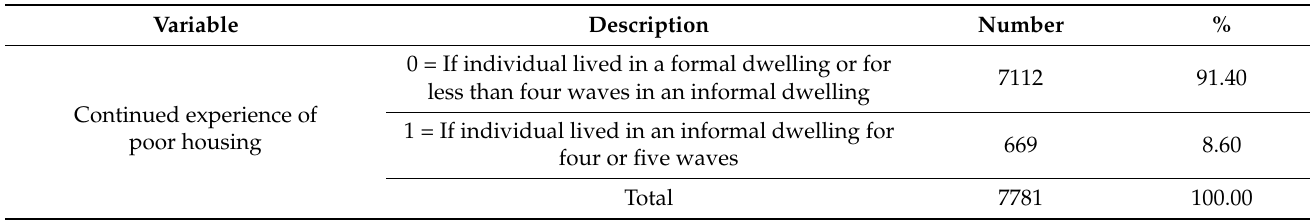
Table 2. Housing constructs and variables.